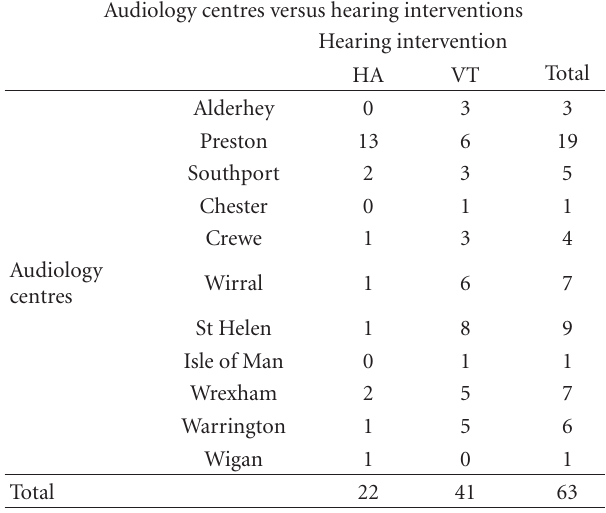
Table 7: Audiology centres and type of treatment